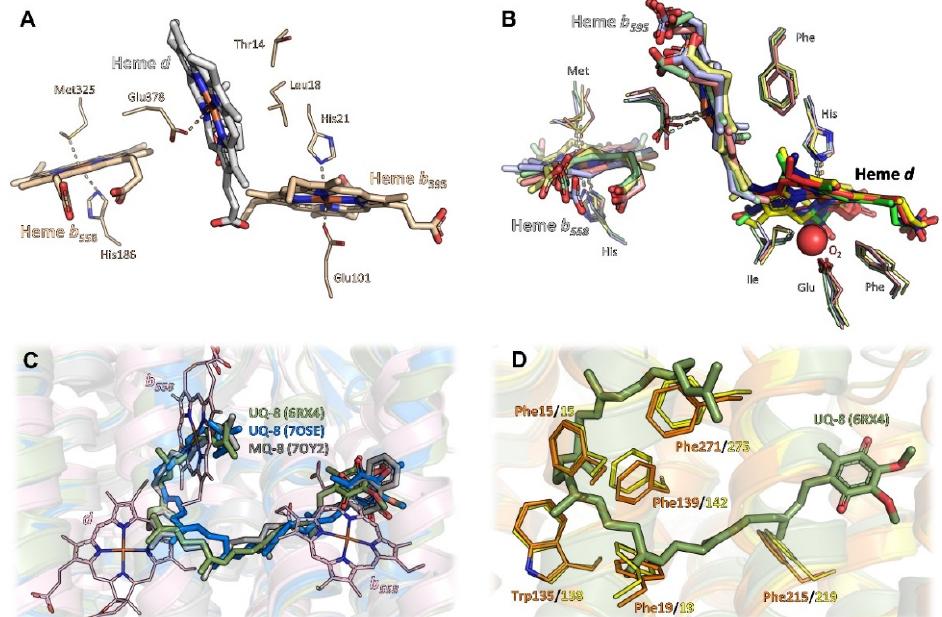
Figure 2. Triangular heme arrangement in CydA/AppC and equivalent positions in CydB/AppB . ( A ) In G. thermodenitrificans , hemes b 558 and b 595 (light beige sticks) are found in a plane, while heme d sits orthogonally on top (grey sticks). Here, the orthogonal heme is the active site. Axial heme ligands of CydA are shown as thick lines. Thr14 and Leu18 form a hydrophobic roof above heme d . ( B ) The heme arrangement in E. coli bd -I (green sticks), E. coli bd -II (blue sticks), as well as the mycobacterial bd s ( M. smegmatis in yellow sticks, M. tuberculosis in red sticks) is conserved and differs from G. thermodenitrificans in the relative position of hemes b 595 and d . Heme b 595 is now orthogonally placed with respect to the plane and replaces heme d (bold colours), which in turn resides in the plane with b 558 (light colours). Nonetheless, heme d (bold colours) remains the active site with molecular oxygen (red spheres) being found as axial ligand in pdb ID 7NKZ ( M. tuberculosis ). ( C ) Superposition of E. coli bd -I subunit CydA with subunits CydB/AppB of E. coli bd -I and bd -II. The Q-loop was removed from CydA prior to superposition. In CydB/AppB, either ubiquinone-8 or menaquinone-8 occupies the position corresponding to the heme groups in CydA. ( D ) Mycobacterial bd s do not employ a quinone in subunit CydB to fill the equivalent positions of the heme groups, but instead utilise aromatic side chains (shown as thick lines, M. smegmatis in orange, M. tuberculosis in yellow) to seamlessly fill the available space. Ubiquinone-8, as found in E. coli bd -I (6RX4), is given as reference in olive-green